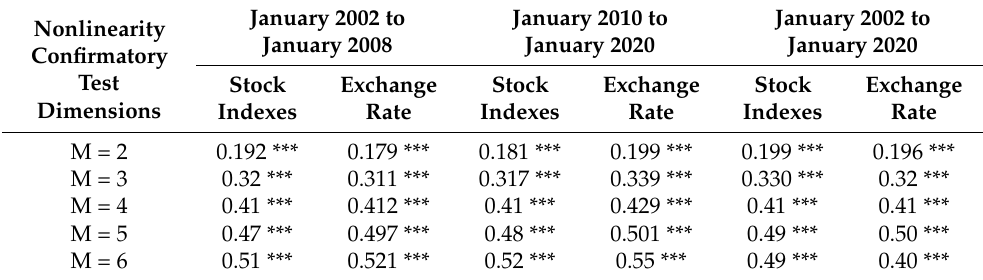
Table 3. BDS test of nonlinearity purposed by Broock et al.